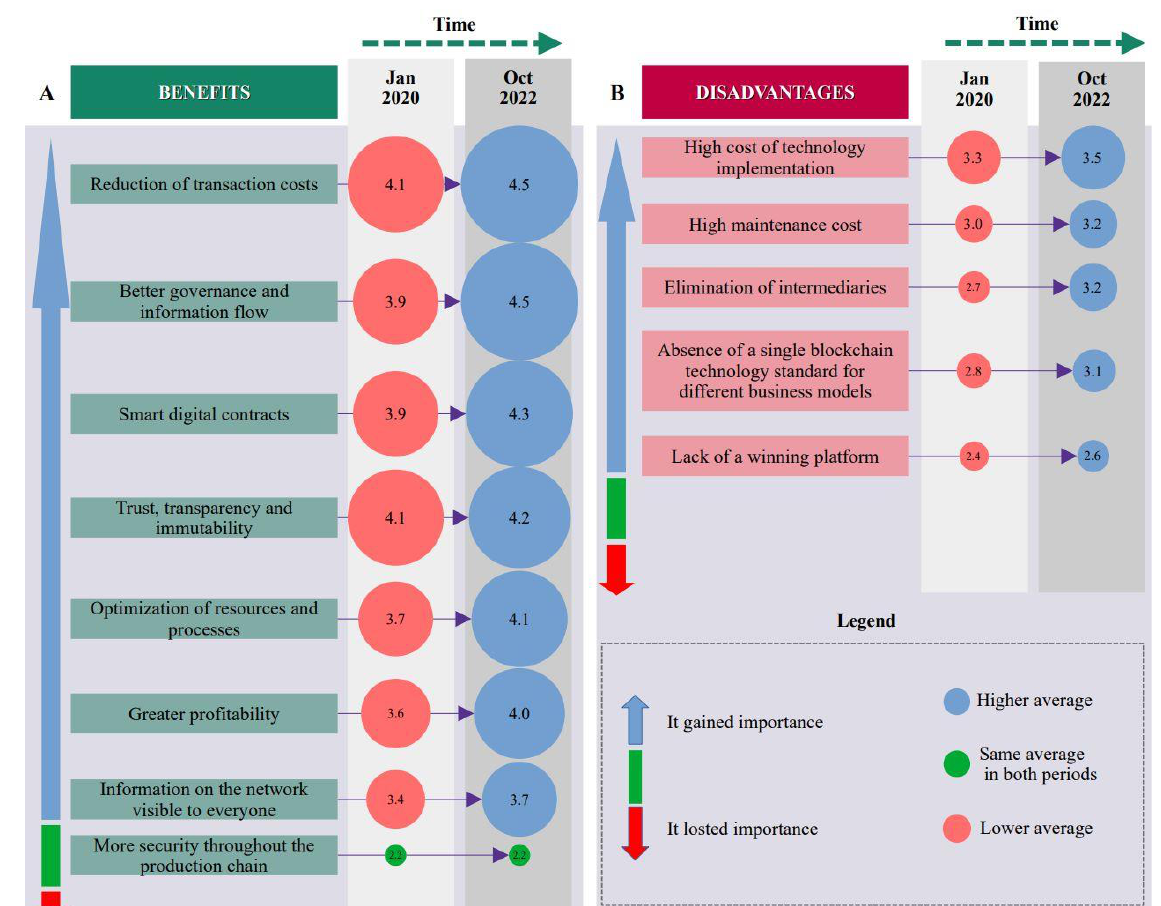
Figure 2. Changes in perceptions of the benefits ( A ) and disadvantages ( B ) of applying blockchain technology in agribusiness. Source: prepared by the authors based on survey data.